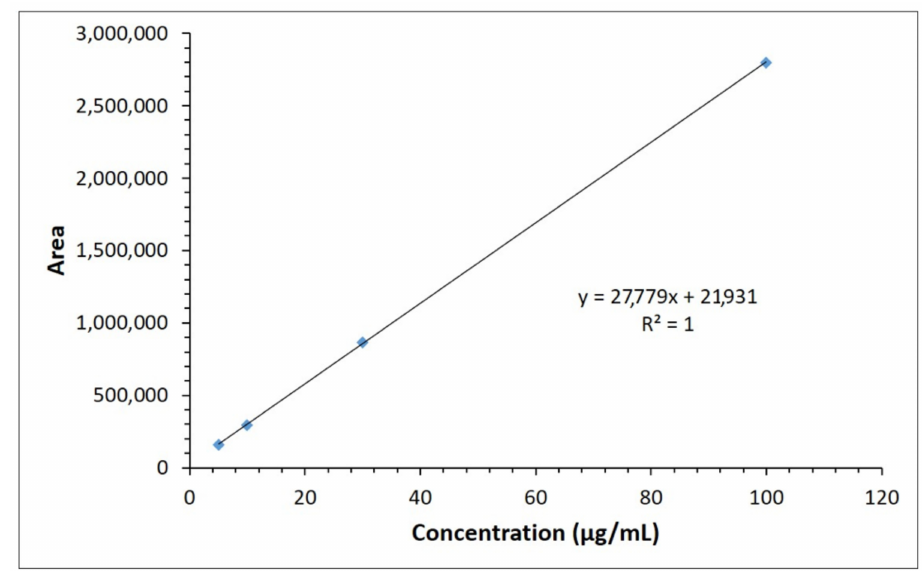
Figure 4. The calibration curve of compound ( 2 ). The chromatographic conditions used were UPLC Acquity C18, column 1.7 µ m (2.1 × 50 mm) maintained at 35 ◦ C temperature, with mobile phase Methanol/water mix. (70/30 % v / v ) at flow rate of 0.1 mL/min. A PDA detector was used at 234 nm wavelength. Table 1. Statistical data of regression equation for the determination of new molecule